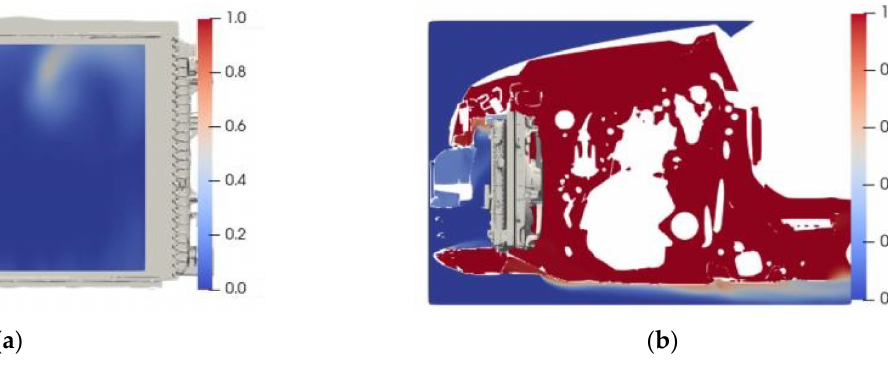
Figure 11. Backflow air distribution of optimized structure. ( a ) Optimized structure front view; ( b ) optimized structure side view. Table 2. Comparison of the backflow rate of the optimized cooling module and the original struc- ture.